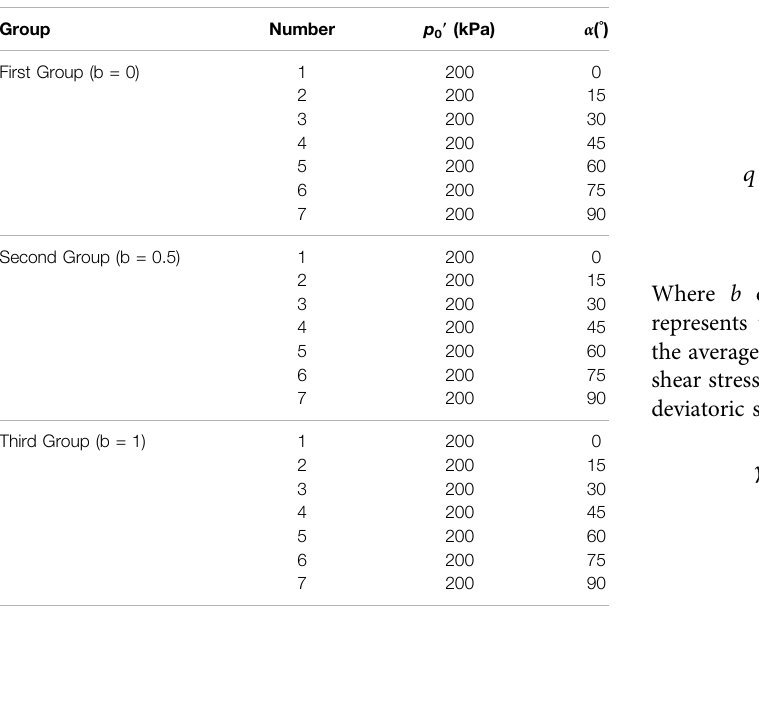
TABLE 3 | Pilot scenarios.